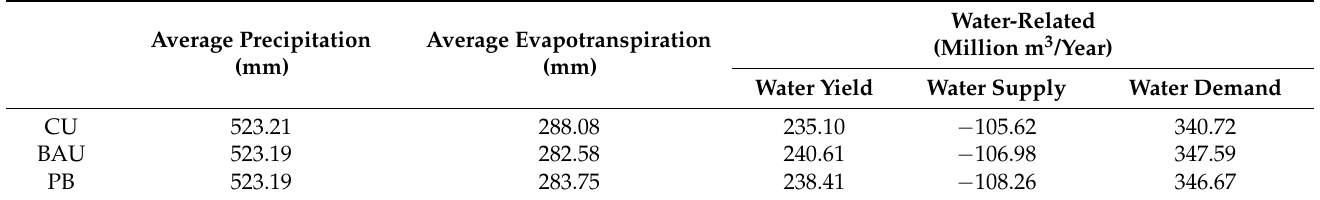
Table 4. The effects of changes in precipitation and evapotranspiration on landscape water yield in CU and two scenarios.